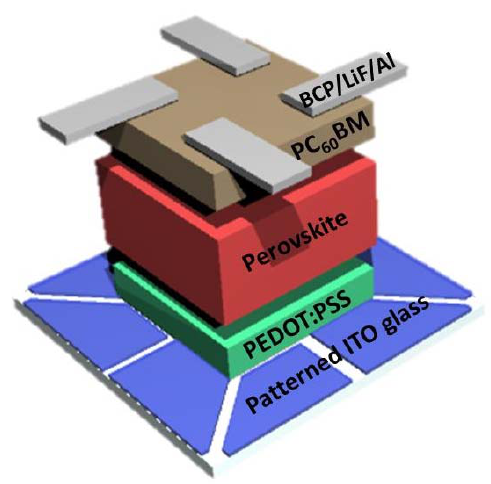
Figure 1. Schematic of inverted planar perovskite solar cells (PSC) device. The PSC is composed of ITO/PEDOT:PSS/CH 3 NH 3 PbI 3-x Cl x /PC 60 BM/BCP/LiF/Al. The single ITO substrate comprised four pixels and the illuminated areas of each pixel were 0.04 cm 2 .